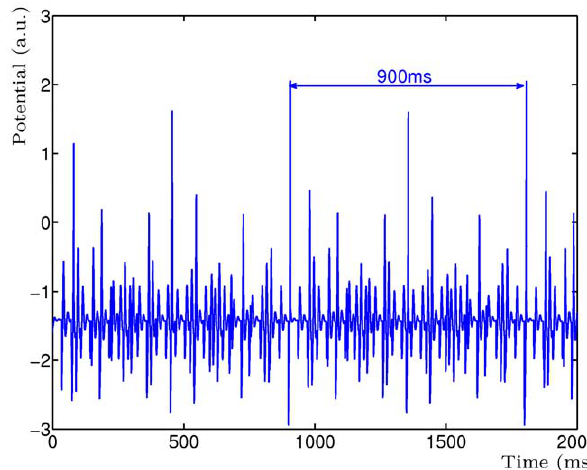
Figure 2. Activity of the read-out neuron V for three input frequencies. Three mutually inhibitory neurons with STD were driven by three frequencies of 13.33 Hz (75 ms), 1.29 Hz (36 ms) and 11.11 Hz (90 ms). The emergent fundamental frequency is 1.11 Hz (900